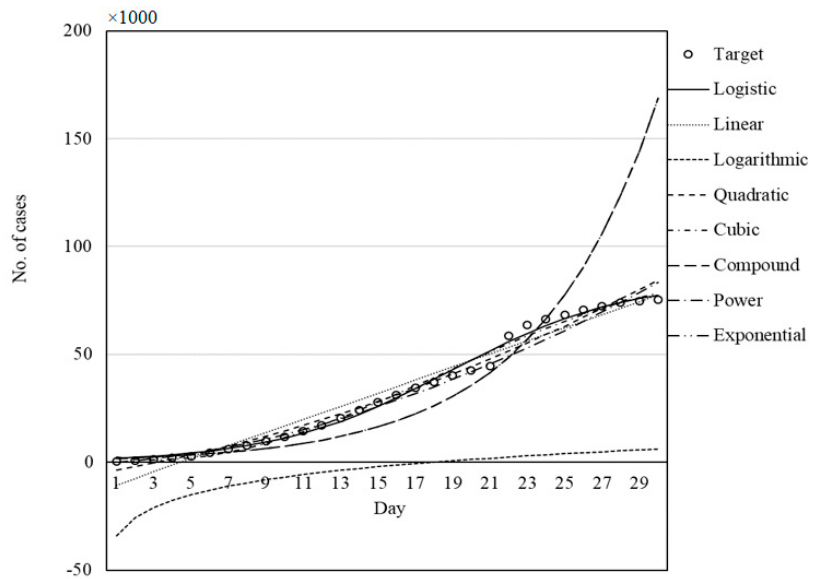
Figure 7. Fitness graph for China fitted by